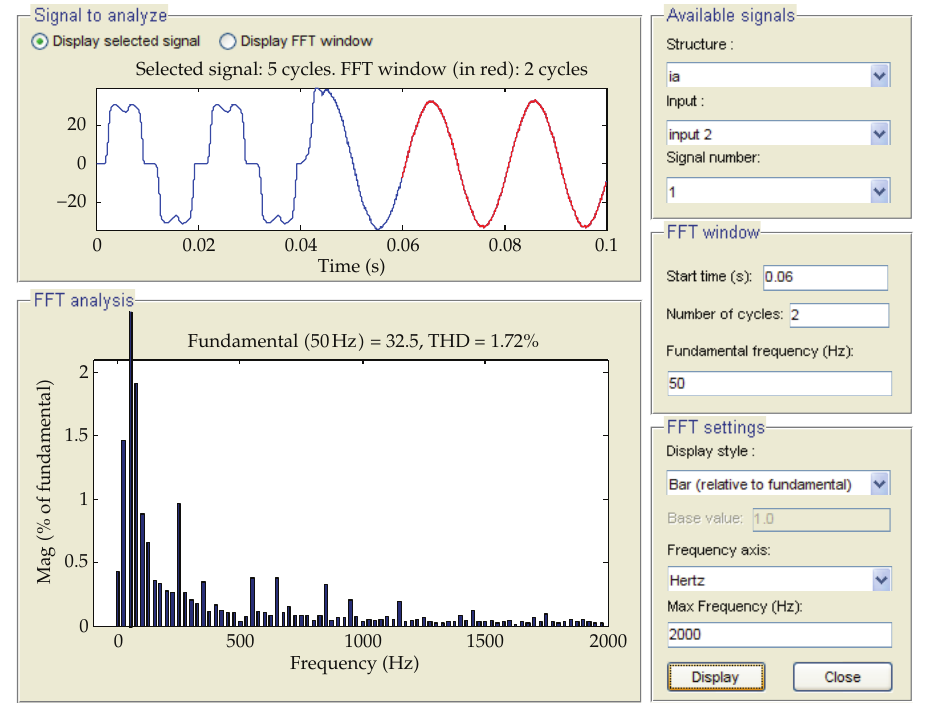
Figure 5: Current harmonic analysis for the last two circles.